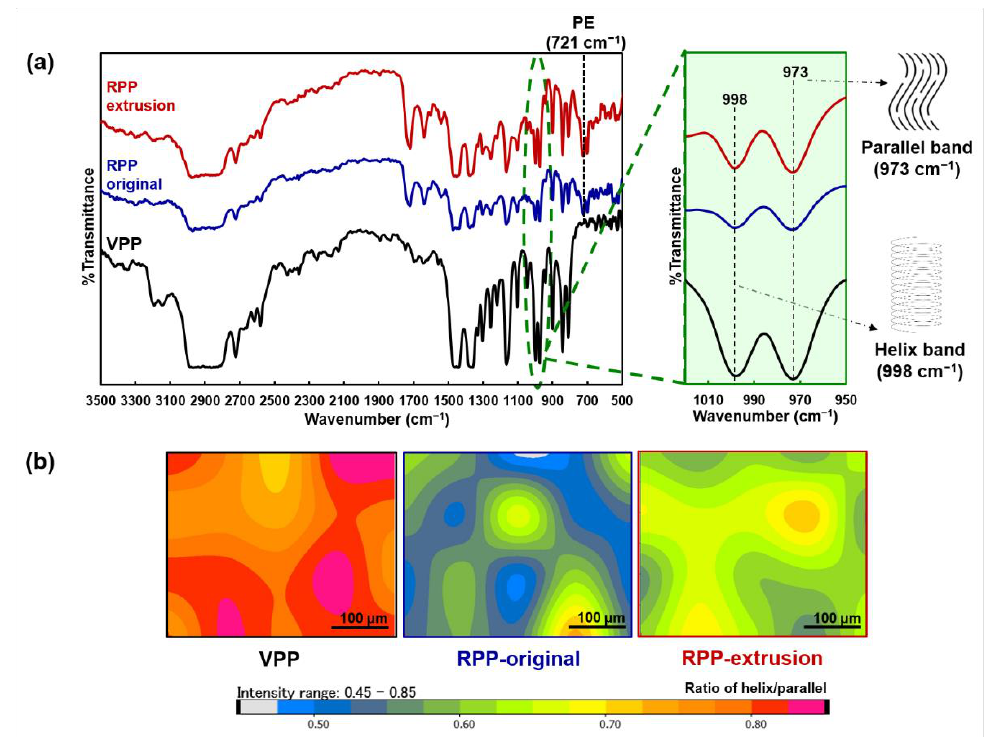
Figure 5. ( a ) IR spectra of VPP, RPP-original, and RPP-extrusion; ( b ) IR mapping for the ratio between the helix and parallel band. parallel